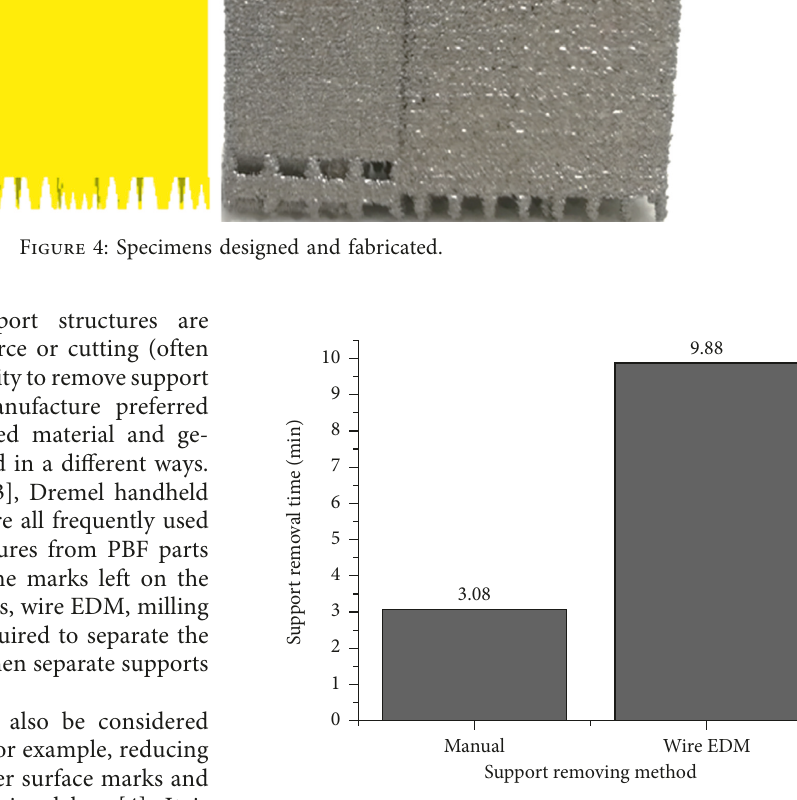
Figure 5: Support-removal time of the manual and wire EDM removal